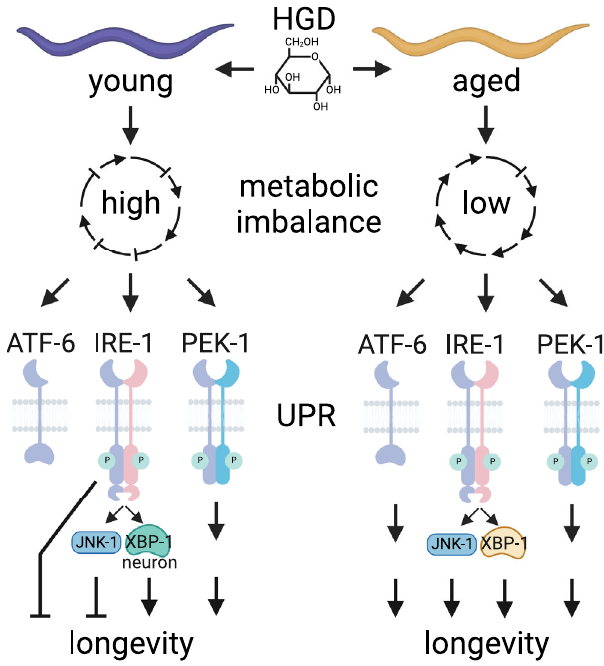
Fig. 7 | HGD-induced UPR modulates longevity differently in young and aged animals. C. elegans fed high glucose diet (HGD) ata young (day 1 of adulthood) or older (day 5 of adulthood) age induces a high and low metabolic imbalance, respectively. In turn, HGD reduces the longevity of young animals in an IRE-1- dependentmannerwhilepromotinganincreaseinlifespanviatheERstresssensors ATF-6 and PEK-1 in aged animals. The proposed model is applicable to chemically- sterilized worms. Created with